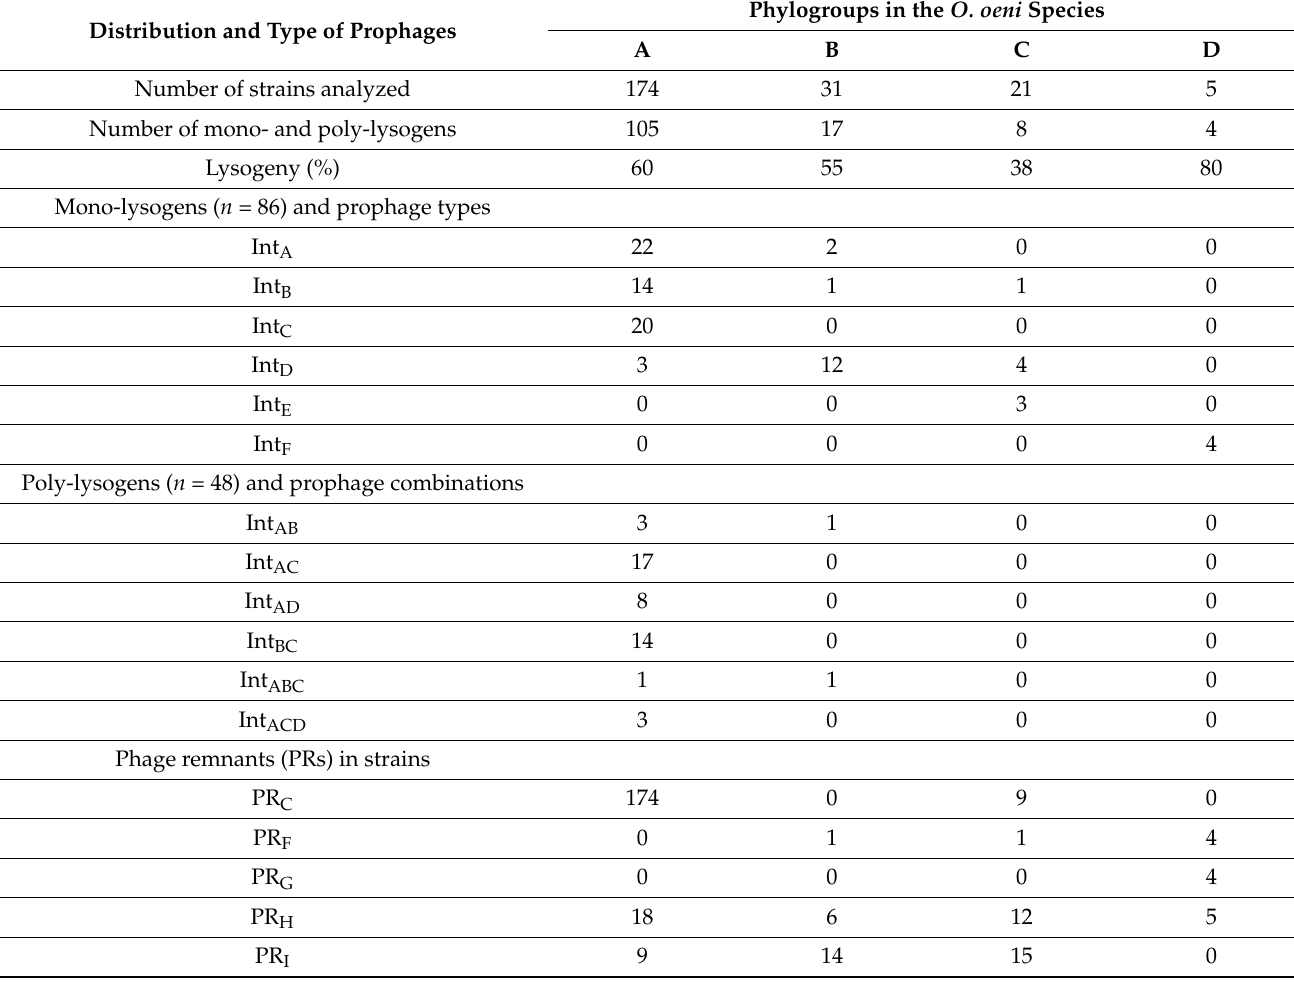
Table 1. Lysogeny in a set of 231 strains representing the four described phylogroups of O. oeni and different combinations of prophage